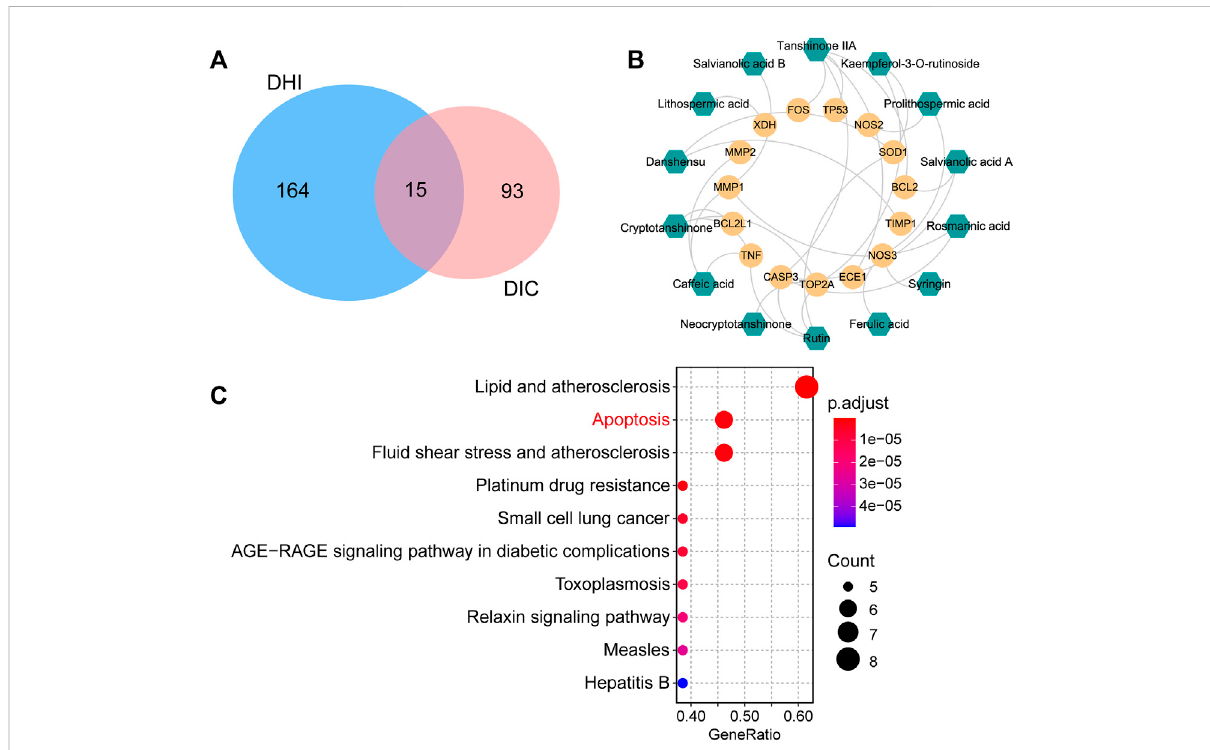
FIGURE 4 Network pharmacology analysis for clarifying the possible mechanisms of DHI against DOX-induced cardiotoxicity. (A) Venn diagram of common targets between DHI and DIC. (B) Active compound – potential target network. The green hexagons represent active compounds and the yellow circles represent potential targets. (C) Top 10 enriched KEGG pathways of the potential targets. DHI: Danhong injection; DIC: DOX-induced